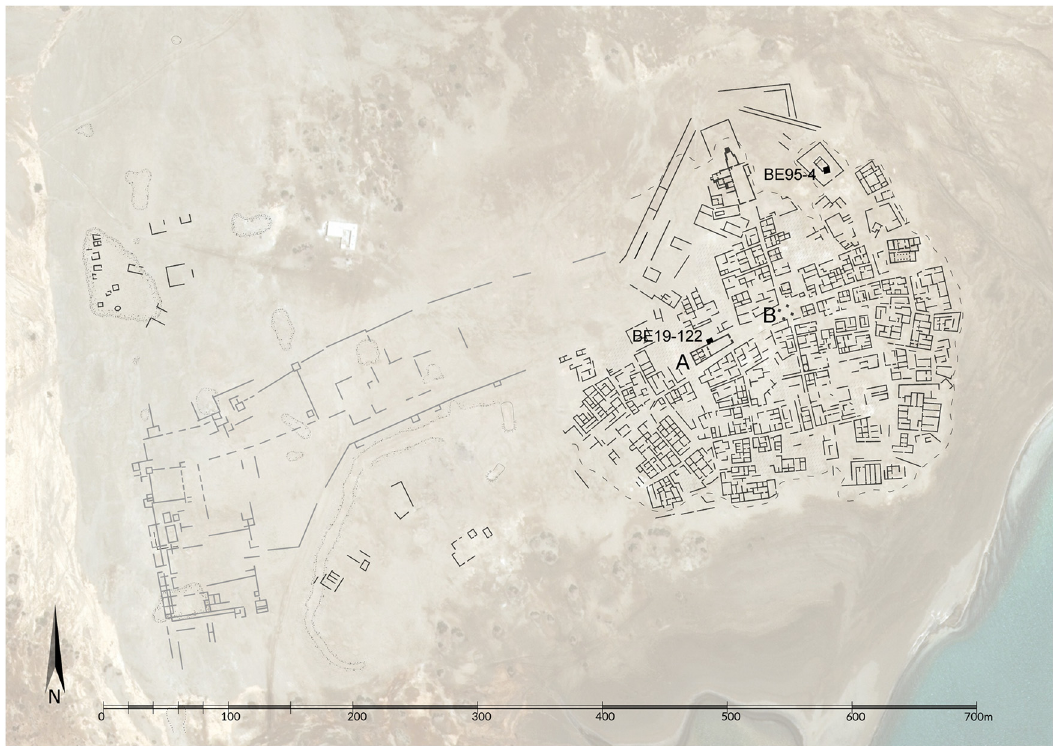
Figure 2: Structures at Berenike with areas mentioned in the text: ( a ) the Isis Temple; ( b ) Tetrastylon; grey – Hellenistic period structures; black – Roman and Late Antique period structures ( drawing: S. Pop ł awski )